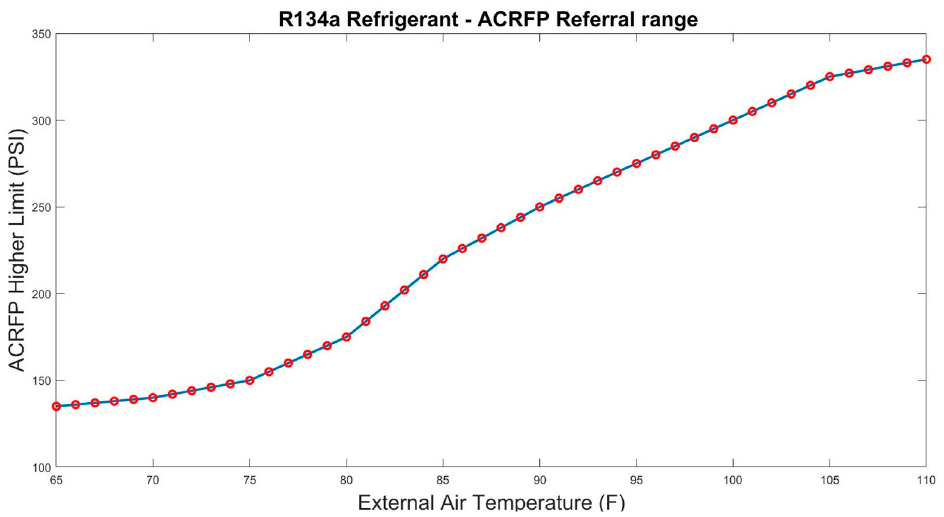
Figure 3. R134a ACS—ACRFP threshold curve.